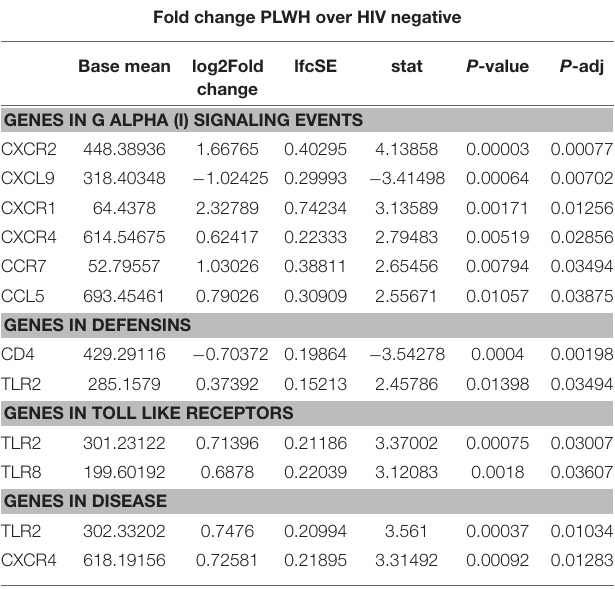
TABLE 4 | RNA gene expression in SAT of PLWH compared to HIV-negative. Fold change PLWH over HIV